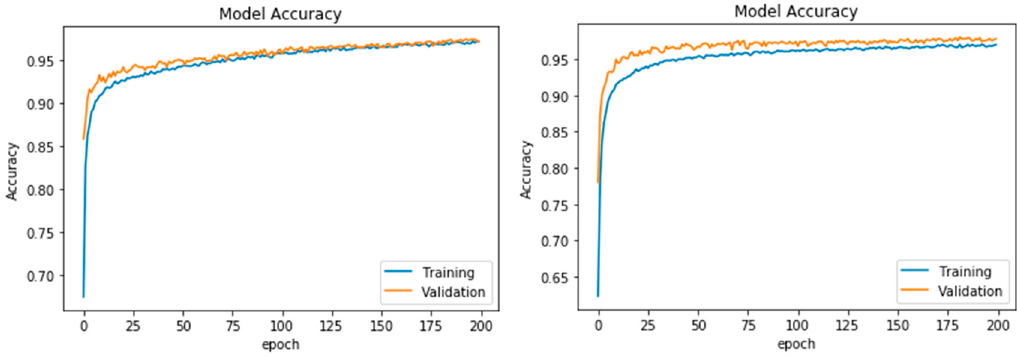
Figure 5. Model accuracy when fusing DSM and RGB (left), and model accuracy with RGB only (right).